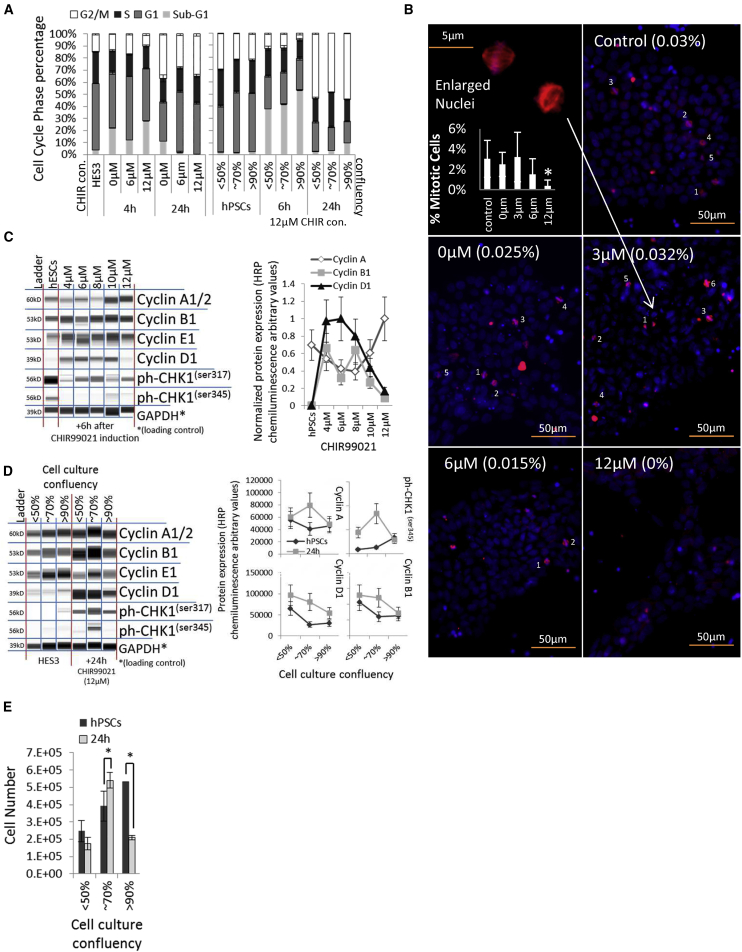
Analysis of hPSC Cell Cycle and Cyclins during CHIR Induction(A) Cell-cycle profile of HES3 cultures after induction with 0–12 μM CHIR, and cell-cycle profile of hPSCs cultured at 50%, 70%, and 90% culture confluency after 12 μM CHIR induction (n = 3).(B) Nuclei; DAPI (blue) and spindle apparatus of mitotic cells; γ-tubulin (red) staining of monolayer HES3 cultures treated for 8 hr with 0–12 μM CHIR. Numbers in brackets give the percentage of positively stained cells (n = 3 with 10 regions of interest each, ∗p ≤ 0.05).(C) Whole-cell protein blot expressions and quantitative analyses of HES3 cells after 4–12 μM CHIR induction.(D) Whole-cell protein blot expressions and quantitative analyses of HES3 cultures at 50%, 70%, and 90% culture confluency after 12 μM CHIR induction.(E) Cell number of hPSC cultures at 50%, 70%, and 90% culture confluency after 12 μM CHIR treatment (n = 3, ∗p ≤ 0.05).